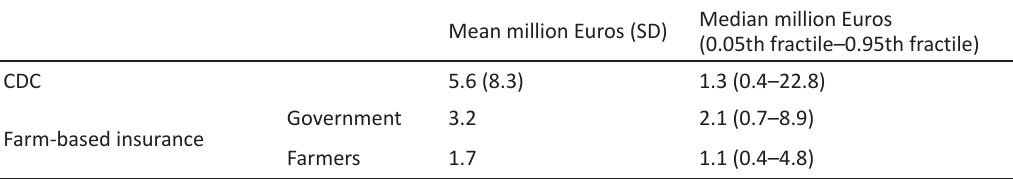
Table 6. Mean and median costs of the farm-based insurance and CDC